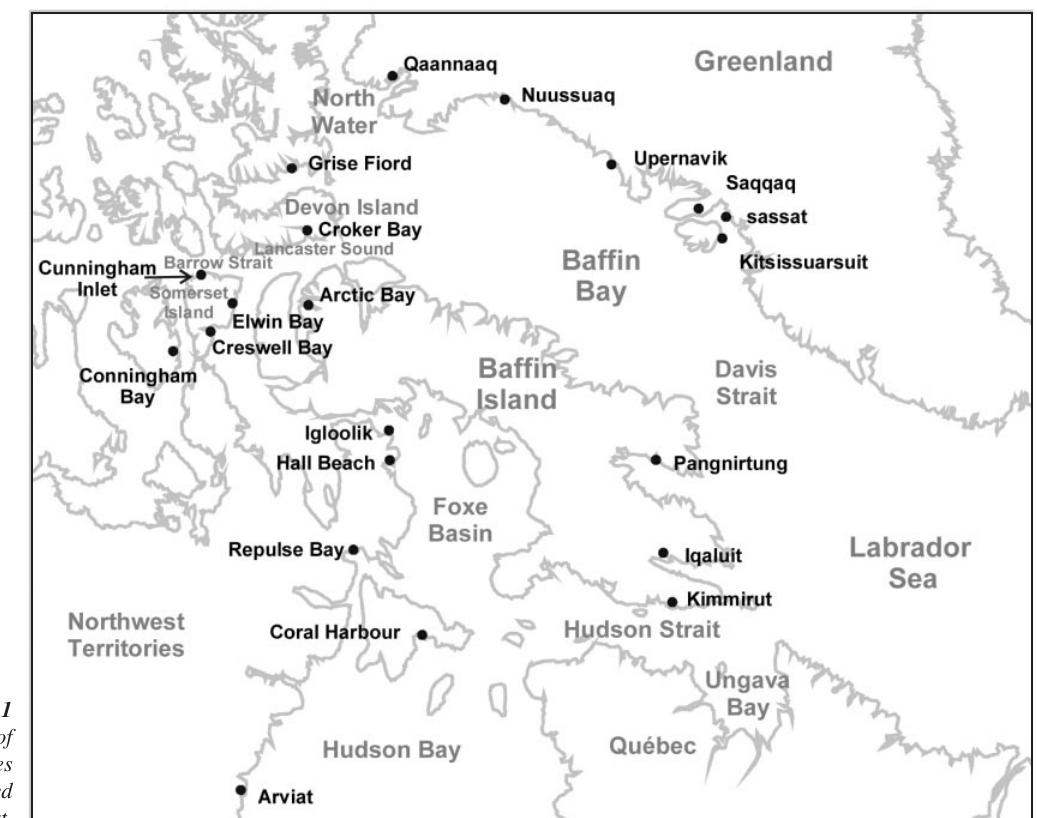
Map of localities mentioned in the